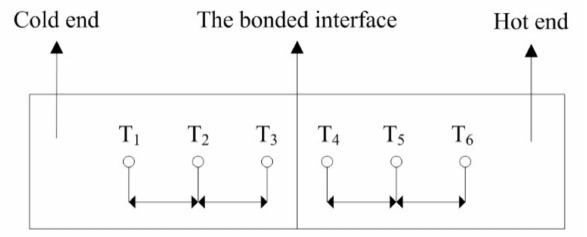
Figure 4. Schematic diagram of the simulation device for thermal property test.